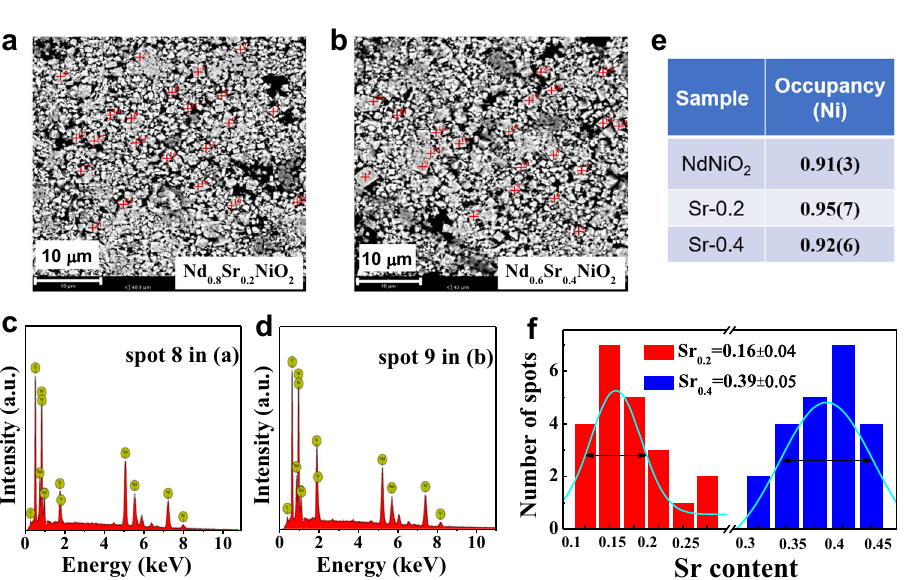
Fig. 2 Scanning electron micrograph images and energy dispersive spectroscopy analyses. a, b SEM images of Nd 0.8 Sr 0.2 NiO 2 and Nd 0.6 Sr 0.4 NiO 2 samples. c, d The typical energy dispersive spectroscopy (EDS) of the spot 8 in (a) and spot 9 in (b), respectively. e The mean value of occupied ratio of nickel in Nd 1 − x Sr x NiO 2 ( x = 0, 0.2, 0.4) samples. f The proportion distribution of Sr concentration by measuring EDS on different grains of the samples. A clear inhomogeneity of strontium content is observed. The strontium content can be addressed as 0.16 ± 0.04 for x = 0.2 sample and 0.39 ± 0.05 for x = 0.4 sample from the Gaussian fi